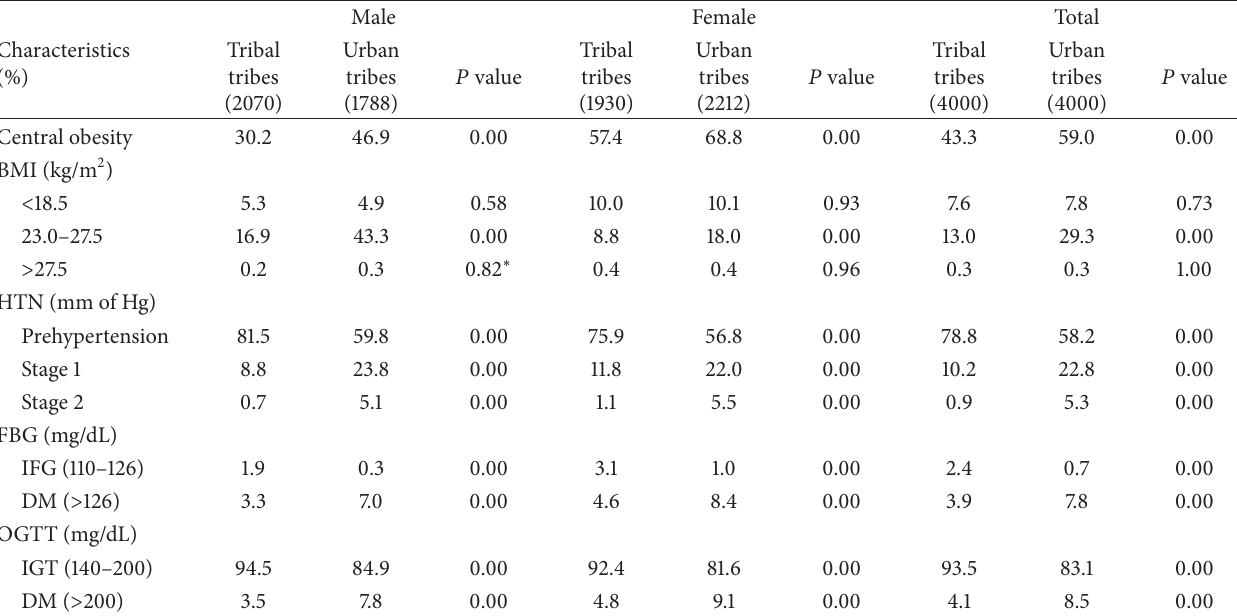
Table 5: Gender distribution for anthropometry, blood glucose, and alcohol consumption among tribes of urban and tribal areas, Himachal Pradesh, 2011-2012. Characteristics